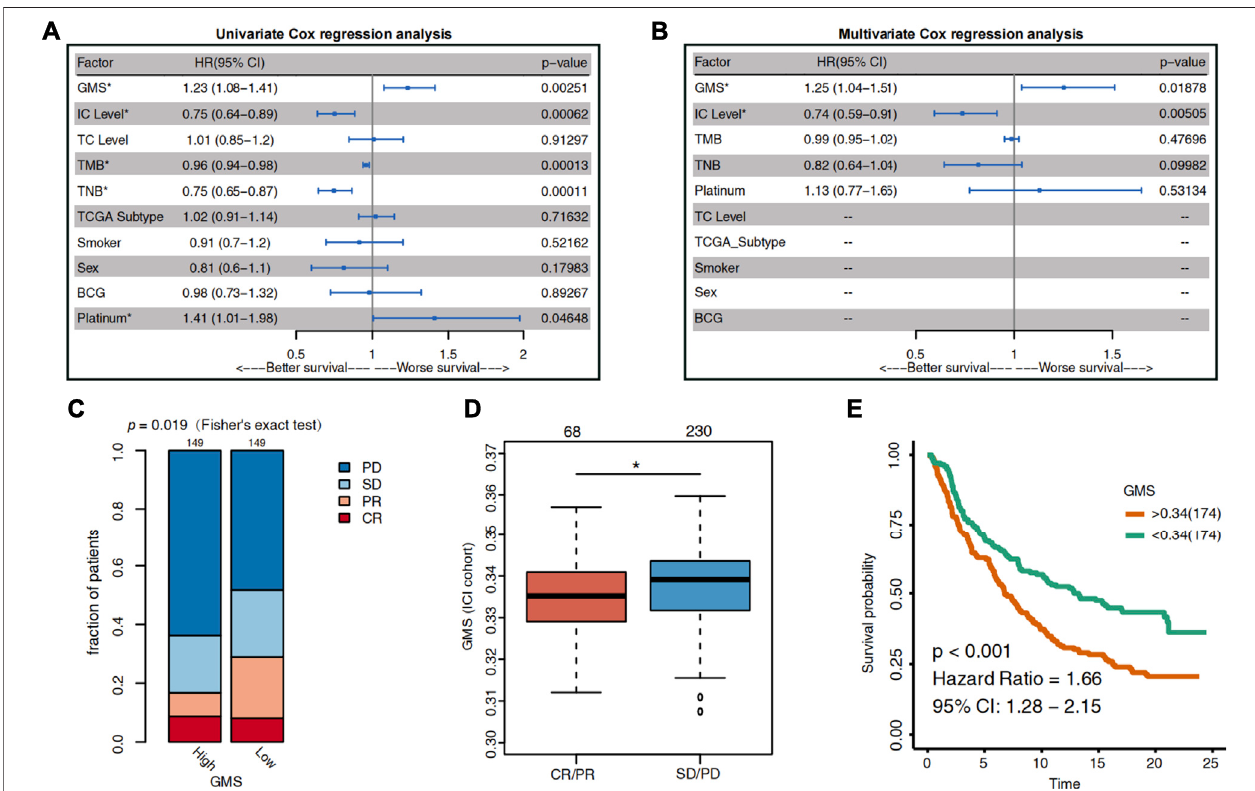
FIGURE 2 | The predictive value of glycogen metabolism for the ef fi cacy of ICI in UC patients. (A) The Forest plot shows the result of univariate Cox regression analysis. The indicators with p < 0.05 were GMS, IC level, TMB, TNB and platinum treatment. (B) The Forest plot visualizes the results of multivariate Cox regression analysis. Results showed that GMS and IC level were independent predictors of ICI in UC patients. The main portion of the plot depicts the hazard ratio (HR) and 95% con fi dence interval (95% CI). The statistically signi fi cant indicators ( p < 0.05) are marked with asterisks after their name, and HR indicates whether the indicator portends a favorable prognosis (HR < 1) or a poor prognosis (HR > 1). (C) Differences in the proportion of UC patients with different response to ICI between high-GMS andlow-GMSpatientsintheICIcohort.CR:completeresponse;PR:partialresponse;PD:progressivedisease;SD:stabledisease. (D) DifferencesinGMSbetweenCR/ PRandSD/PDpatients.Theasteriskabovetheboxplotindicatestherangeof p values. “ . ” : p < 0.1; “ * ” : p < 0.05; “ ** ” : p < 0.01; “ *** ” : p < 0.001. (E) Kaplan-Meiersurvival curves for OS in high-GMS ( n (cid:1) 174) and low-GMS ( n (cid:1) 174) patients of ICI cohort.